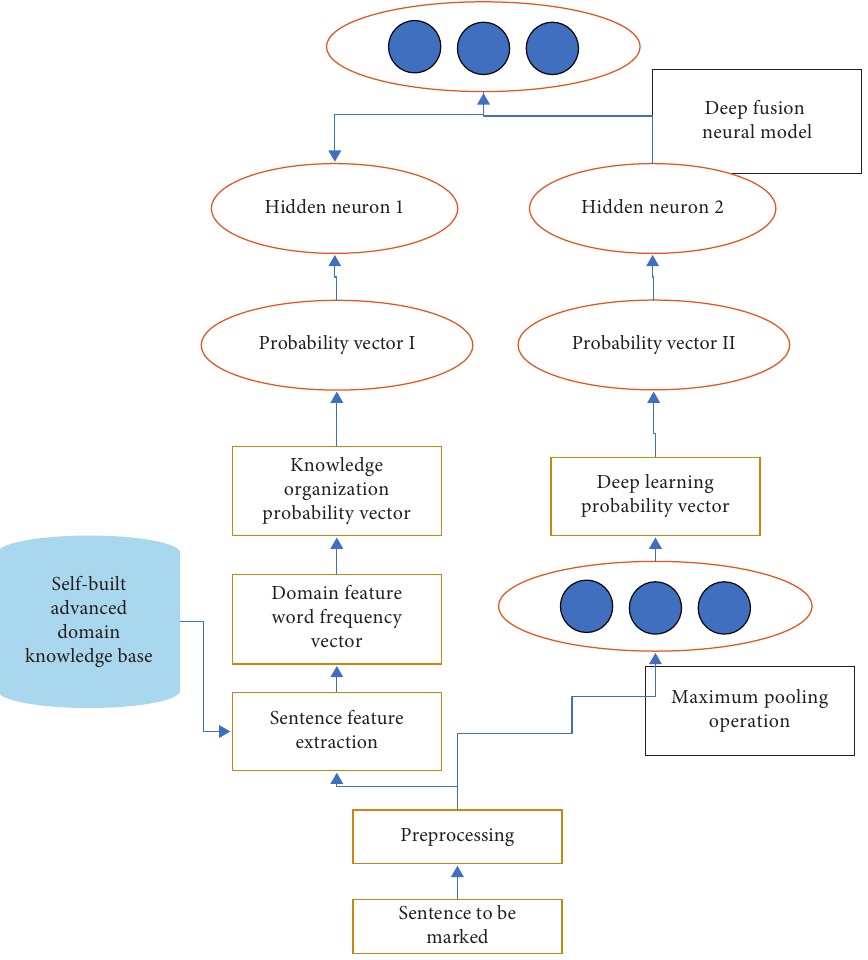
Figure 3: Neural network deep fusion model framework. Table 3: Experimental environment. Table 4: Source of experimental